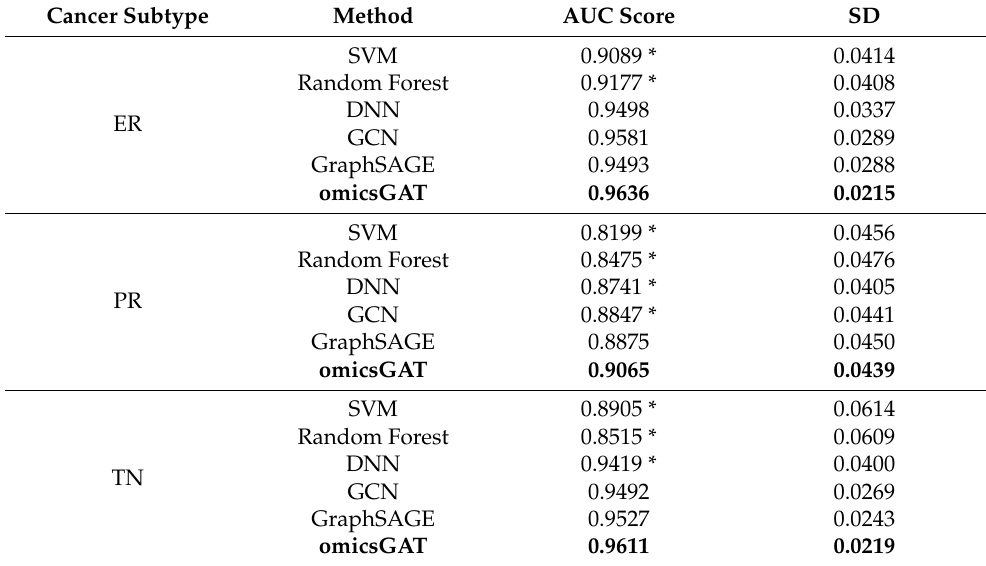
Table 1. The classification performance on TCGA breast cancer (BRCA) dataset. The mean AUROC scores and standard deviation (SD) of classifying patients in breast cancer subtypes are